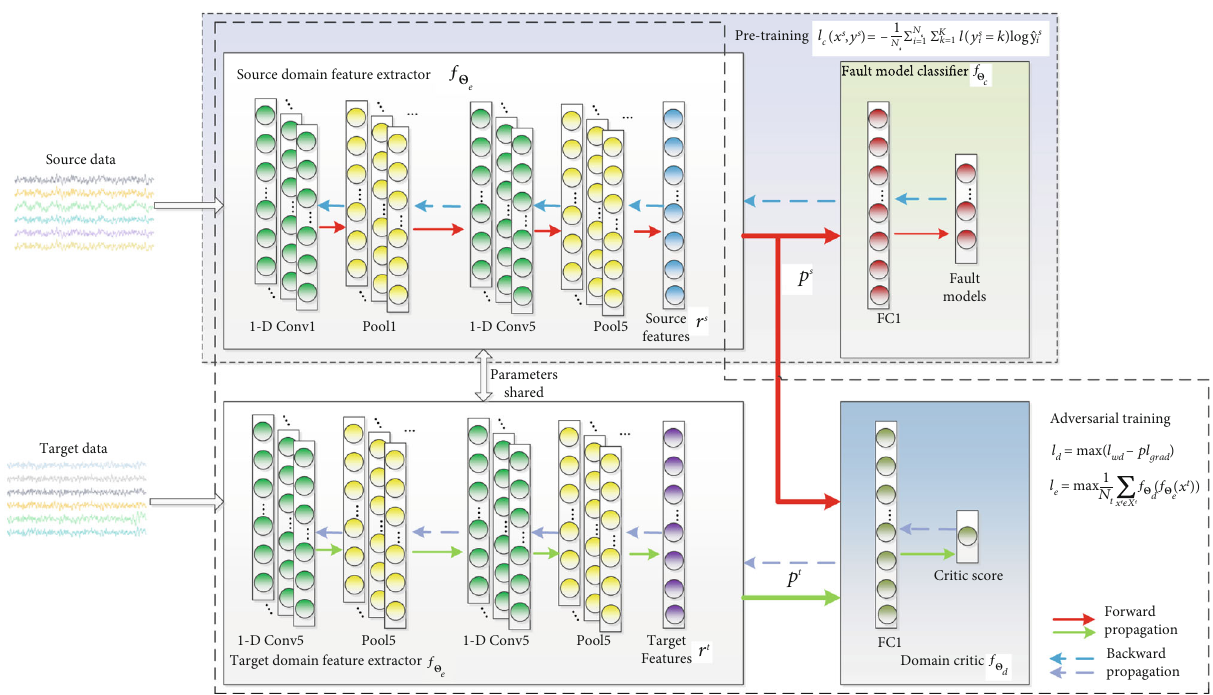
Figure 4: The framework of proposed